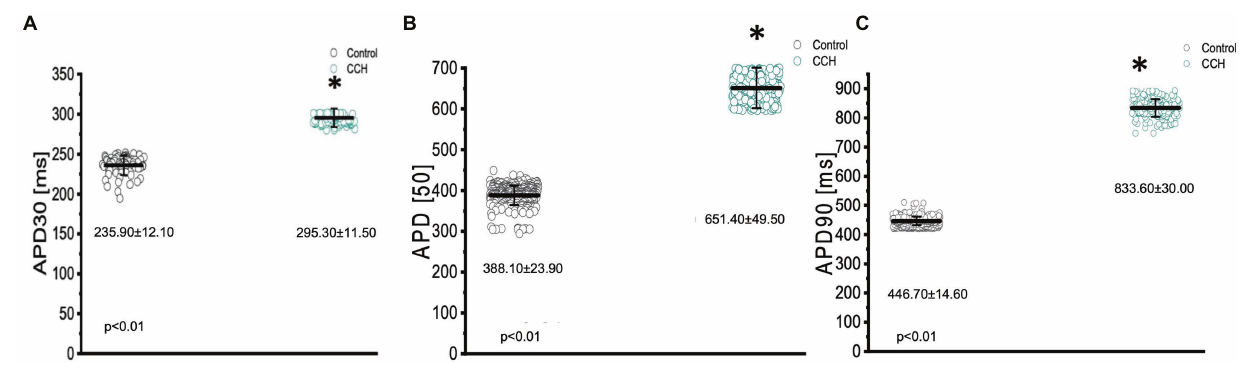
FIGURE 8 | Kinetic parameters of the Goldfish ventricular action potential before (black) and after (green) perfusion with 5 μ m carbamylcholine. APD30 significantly increased from 235.90 ± 12.10 ms to 295.30 ± 11.50 ms ( p < 0.01, n = 80 for the control, n = 49 for CCH, N = 4; A ), APD50 significantly increased from